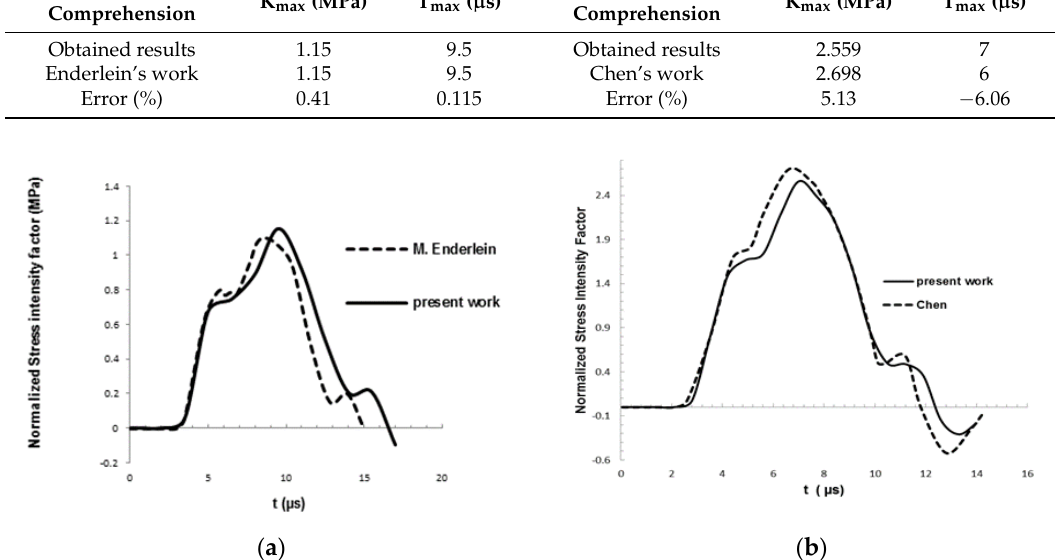
Figure 2. Dynamic stress intensity factor (DSIF) (k I ) versus time of ( a ) BaTiO 3 and ( b ) steel plates.